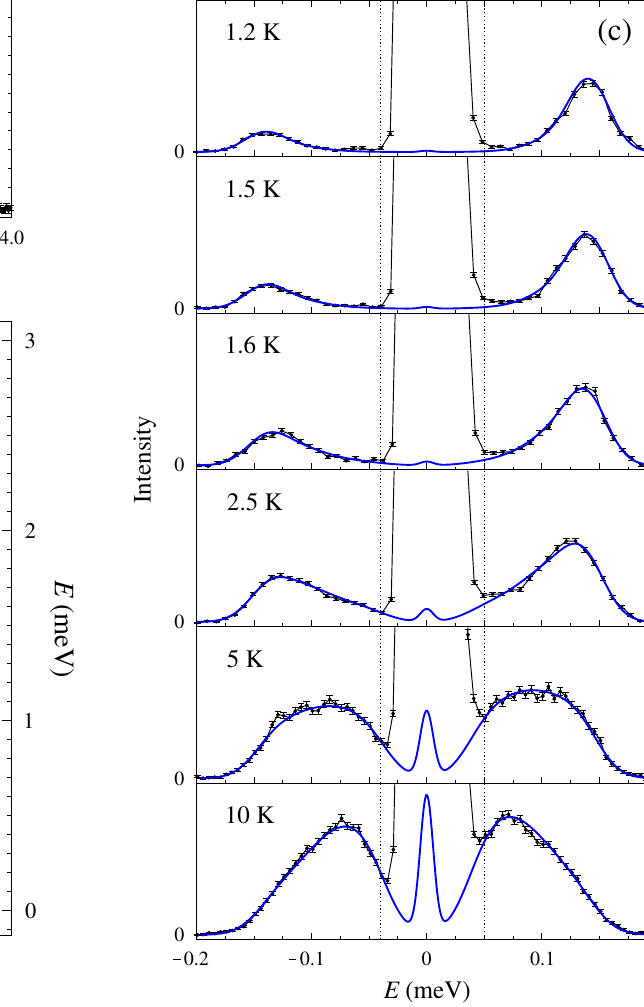
Figure 4. ( a ) Inelastic spectra measured on LET at 35 mK. Data below 1 meV are for incident energy E i = 2.00 meV and data above 1 meV are for E i = 5.15 meV (with a linear background subtracted). Gaussian fits to bands II to IV are indicated, with fit parameters given in Table 4. ( b ) The assignment of band I is the lowest ∆ S = 0 transition of the S = 35/2 multiplet. Bands II to IV are due to magnetic-dipole-allowed transitions with ∆ S = 0, +1, or − 1. On the basis of width, amplitude, and Q dependence, bands II and III are assigned to two distinct S = 35/2 excited states and band IV to unresolved transitions into excited states with ∆ S = ± 1. One possibility is shown here for band IV with transitions to the S = 33/2 and S = 37/2 states. ( c ) The temperature dependence of the low energy spectral region allows two low lying excited spin states to be identified. The blue lines show the fitted thermal dependence that is well described by three spin states, with the corresponding fit parameters given in Table